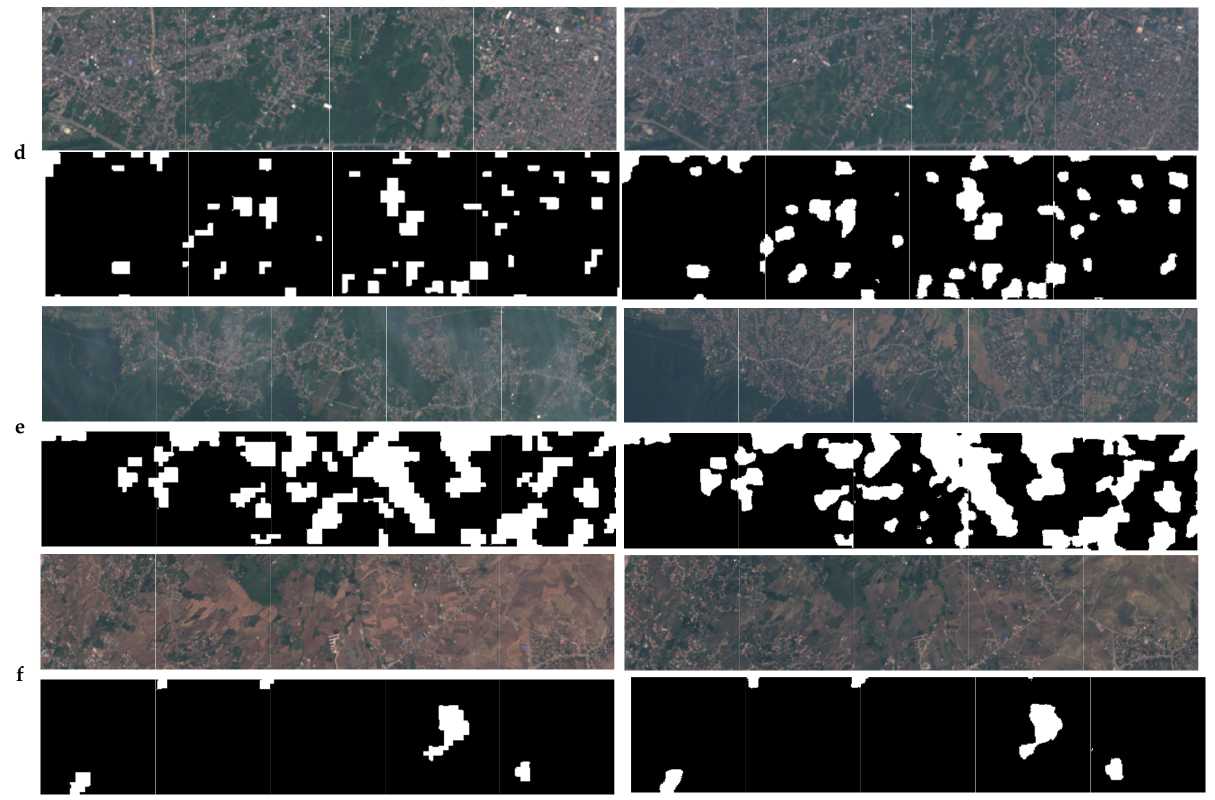
Figure 7. Proposed method results for coastal areas ( a , b ), urban areas surrounded by forest or agricultural land ( c – e ) and urban areas located on foothills ( f ) (top row contains Time 1 (2017) and Time 2 (2021) images, respectively; bottom row contains ground truth and proposed method results, respectively).